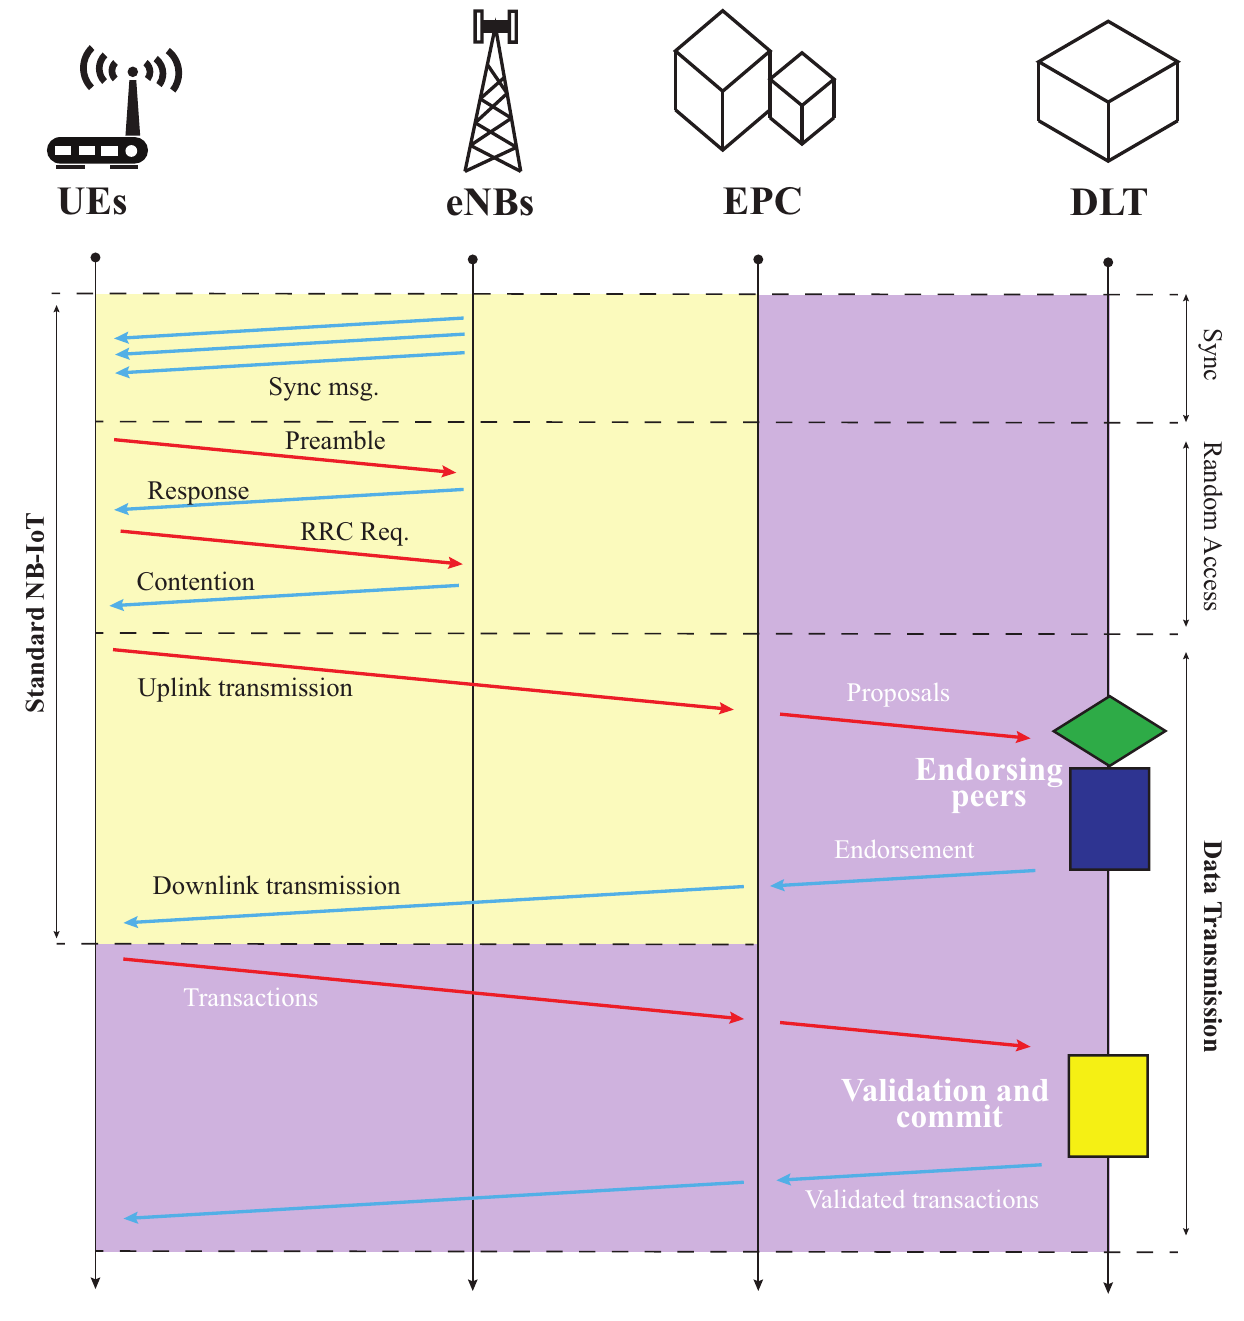
Figure 2 ). Then, each of the peers signs the transaction using the elliptic curve digital signature algorithm (ECDSA) and adds the signature before returning the signed message back to the IoT devices